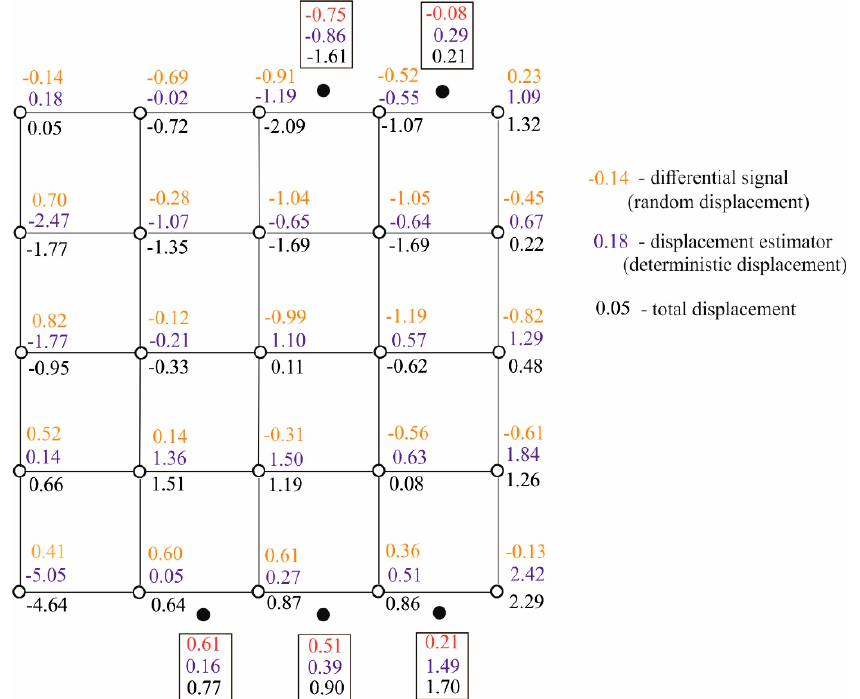
Figure 3. Random, deterministic, and total displacements of points within the simulated free control network (in mm).